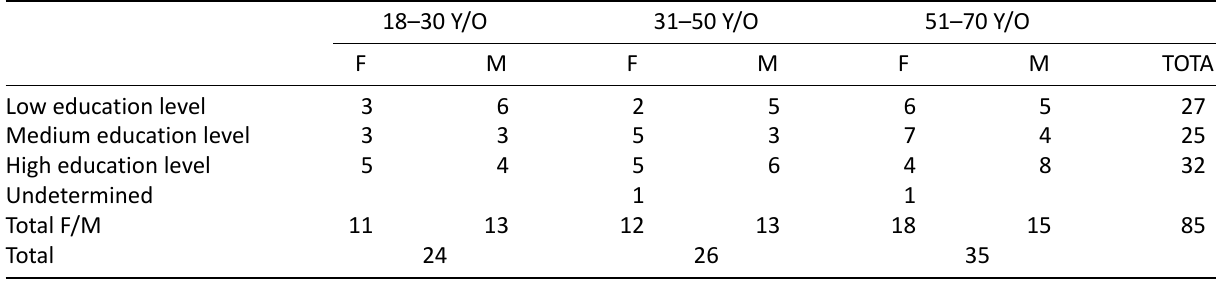
Table 1. Overview of the